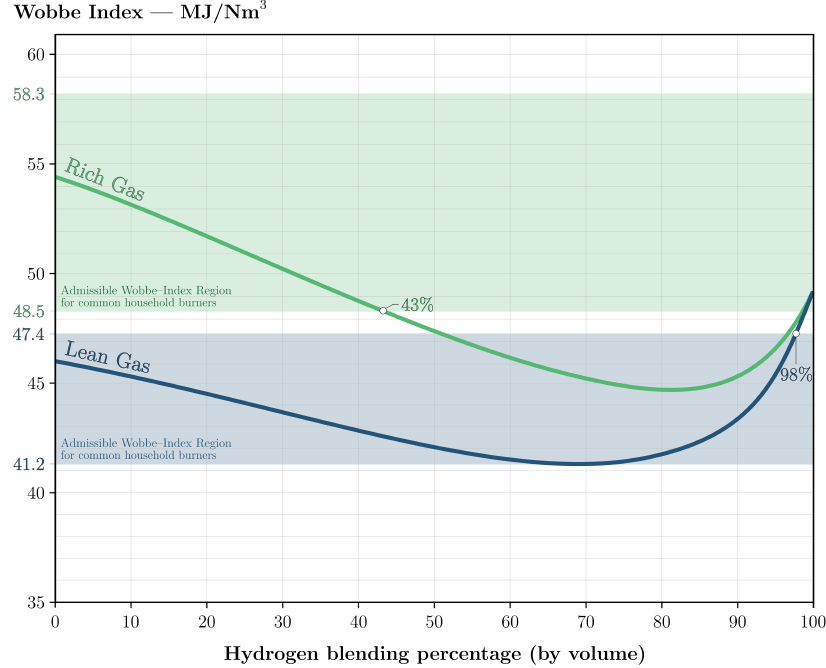
Figure 11. Behavior of the Wobbe Index for different hydrogen contents in natural gas